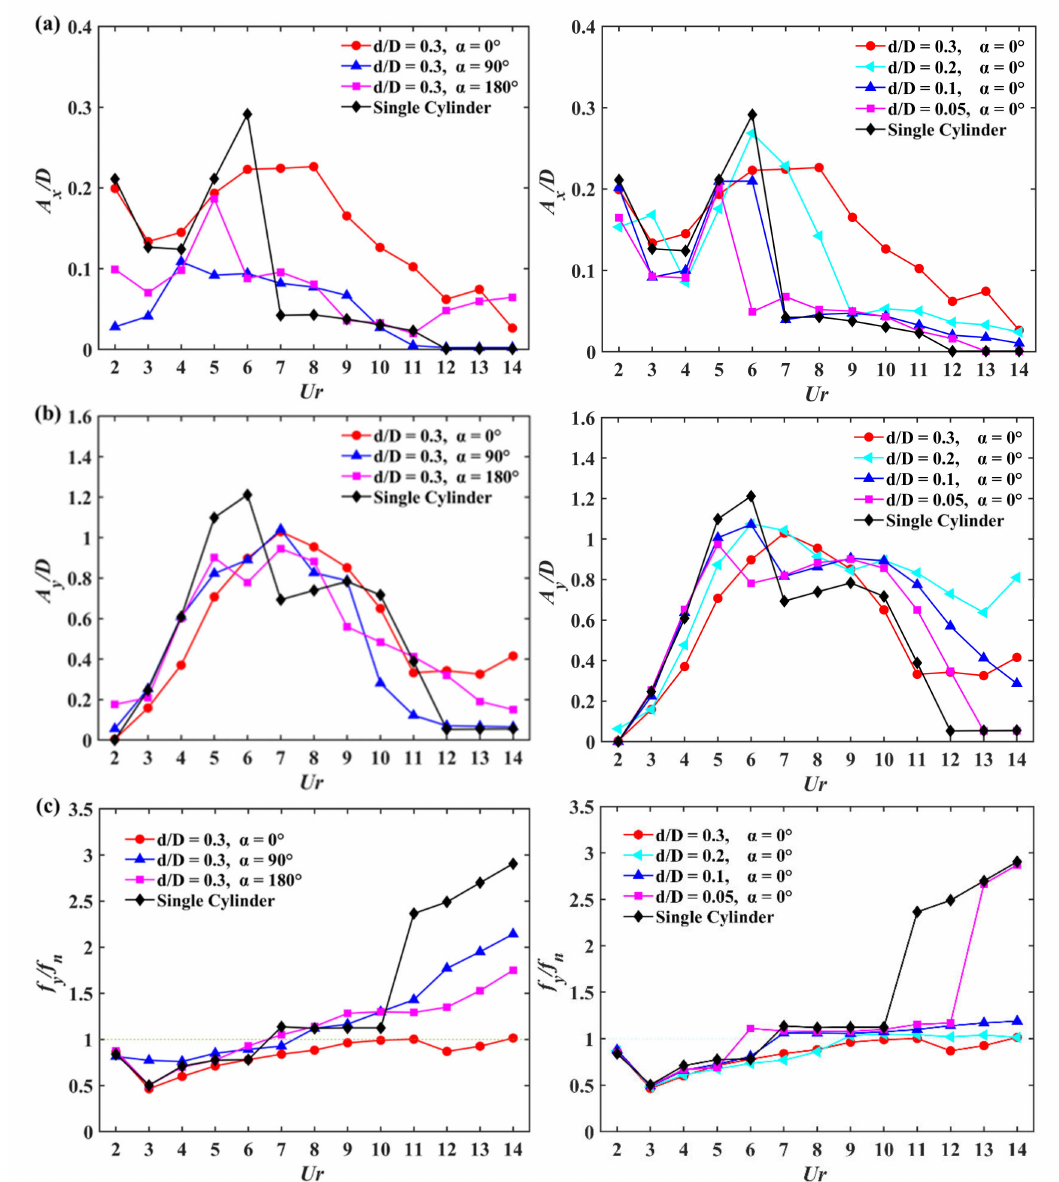
Figure 3. Variations in the non-dimensional vibration amplitudes and frequency ratio with the reduced velocities at different incident angles and diameter ratios: ( a ) streamwise amplitudes; ( b ) transverse amplitudes; ( c ) frequency ratio in the transverse